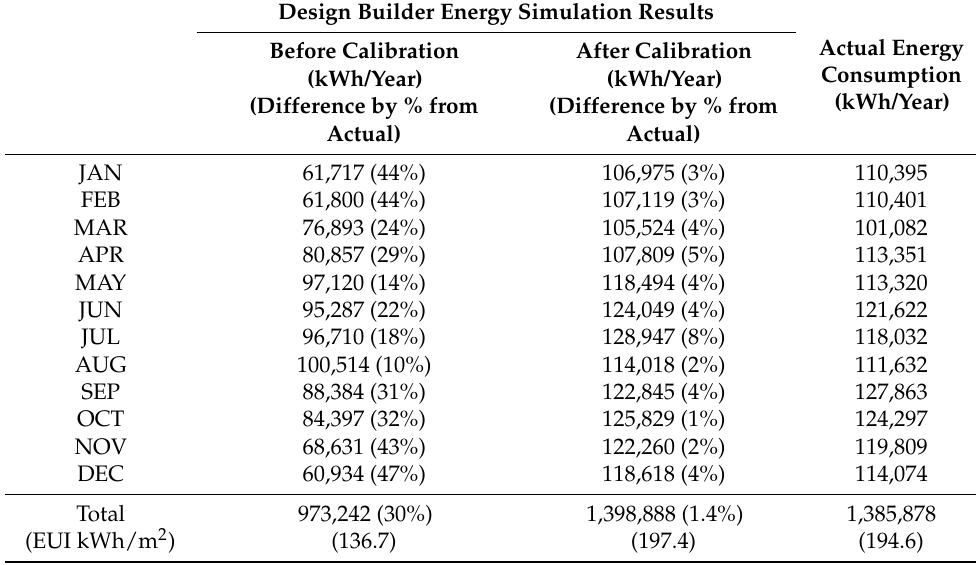
Table 6. Before and after calibration of energy simulation results and actual energy consumption of the case study building in